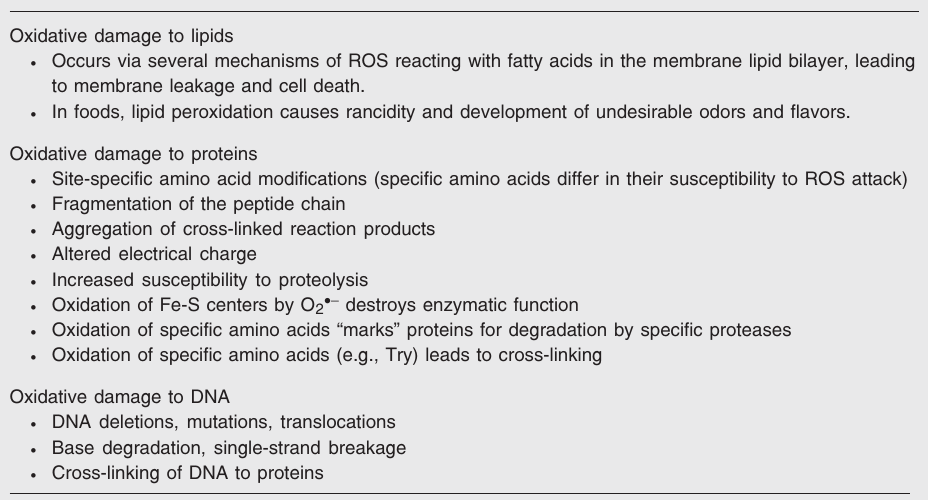
Table 2. Examples of reactive oxygen species (ROS) damage to lipids, proteins and